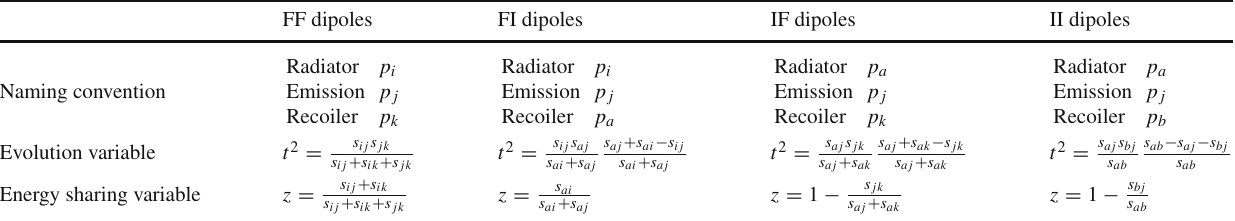
Table 1 Kinematical definitions used in the Dire splitting functions. Note that s rs = 2 p r p s , and that κ 2 = t 2 / Q 2 , where Q 2 is the total dipole squared invariant mass. More details can be found in [38] FF dipoles FI dipoles IF dipoles II